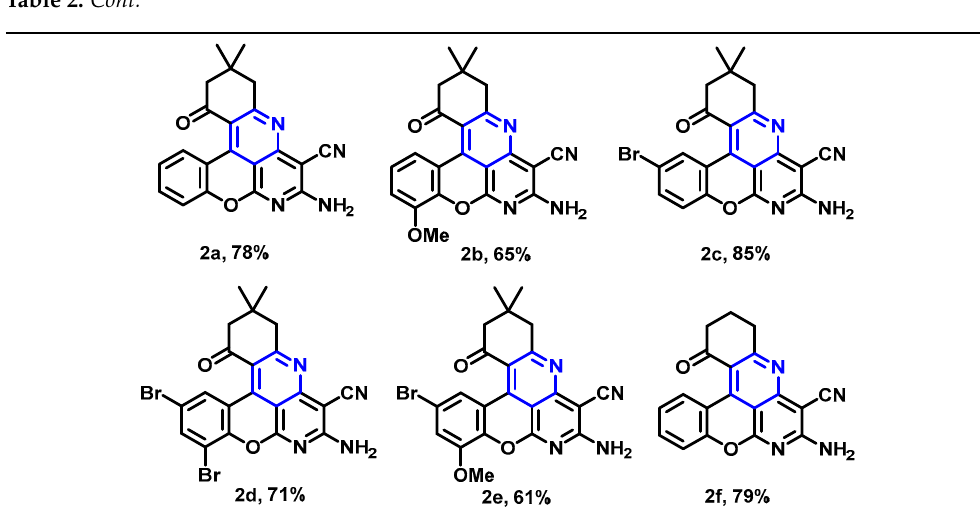
Figure 1. The structure of compound 2a . Key 1 H- 13 C-HMBC spectrum correlations established by NMR are shown by arrows.